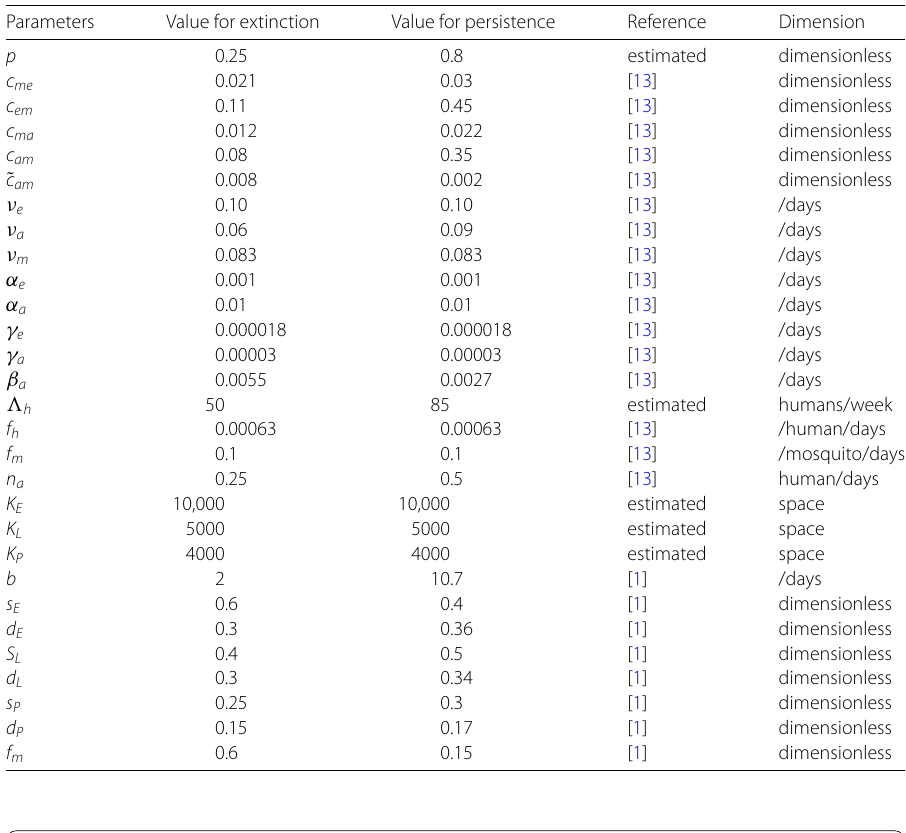
Table 7 Human and vector parameter’s values for the malaria model Parameters